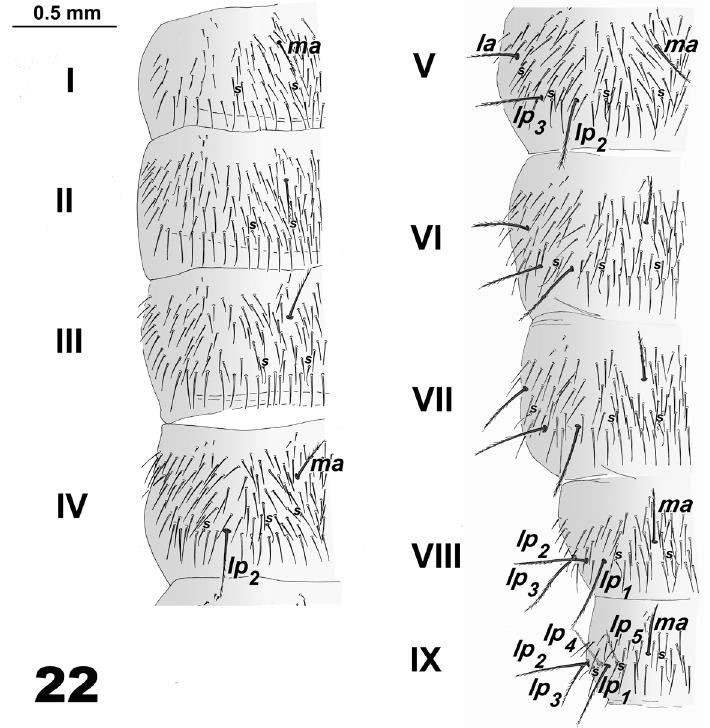
Figure 22. Haplocampa wagnelli Sendra, sp. n. Urotergites I–IX, left side,